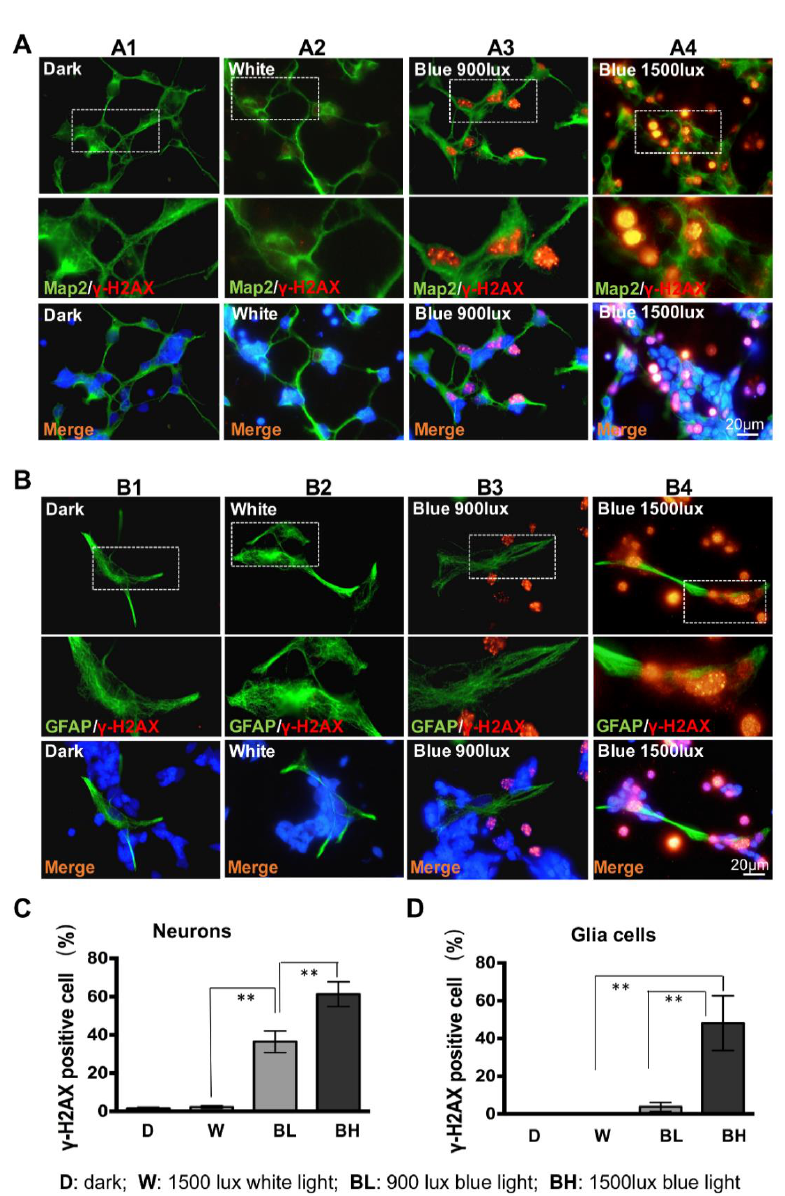
Figure 3. Retinal neurons are more vulnerable than glia cells following blue light exposure. ( A ) Double staining for Map2 and γ -H2AX in neurocytes with or without light exposure. ( B ) The γ -H2AX positive retinal neurons cell numbers are presented as histogram. ( C ) Double staining for GFAP and γ -H2AX in glia cells with or without light exposure. ( D ) The γ -H2AX positive retinal glia cell numbers are presented as a histogram. The magnification of the γ -H2AX foci of the white dotted box area are represented. Error bars represent mean ± SD. Asterisks indicate statistically significant differences between control and experimental samples (** p < 0.01).